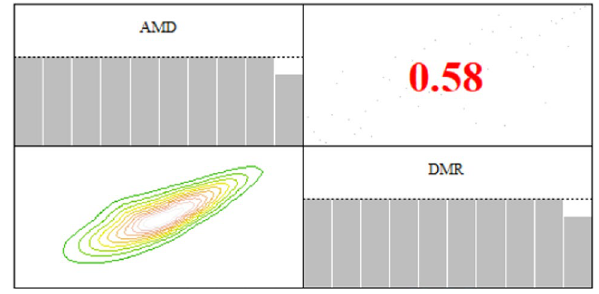
Fig. 2 Kendall’s tau, histogram and empirical contour of AMD and DMR